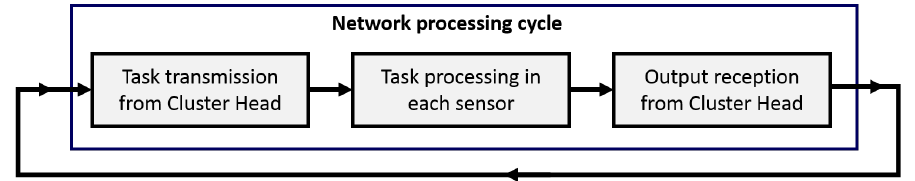
Figure 1. Representation of the network processing cycle: firstly, the information is sent from the cluster head to the sensors, then it is processed, and finally, the outputs are